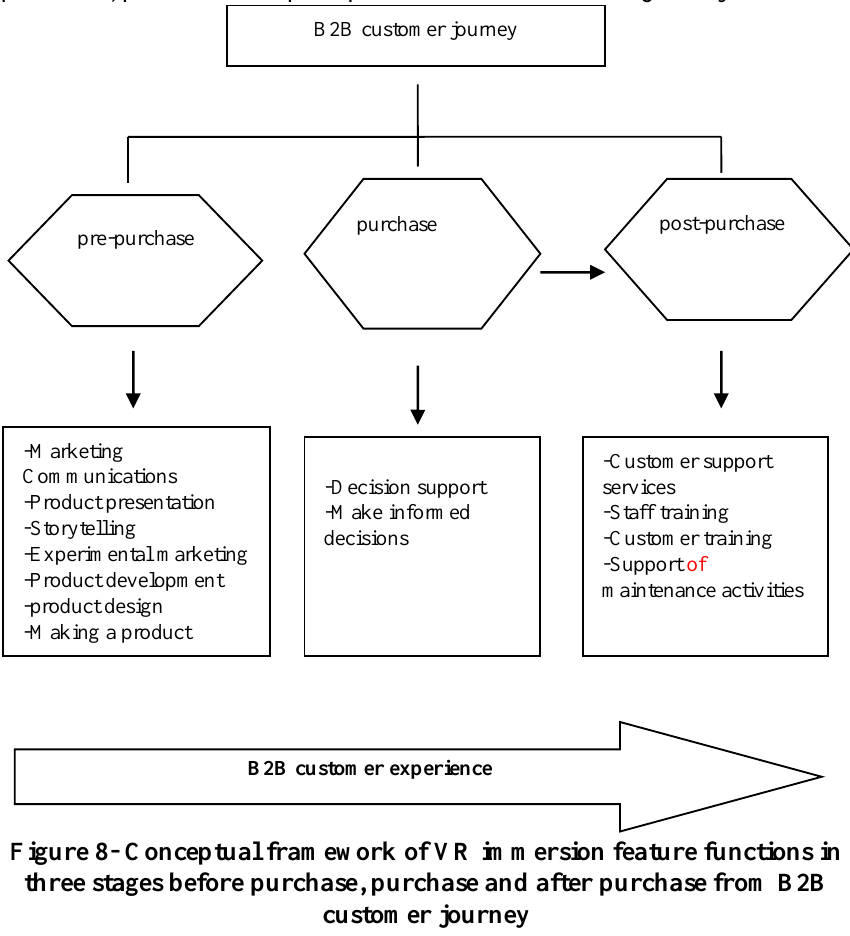
Figure 8- Conceptual framework of VR immersion feature functions in three stages before purchase, purchase and after purchase from B2B customer